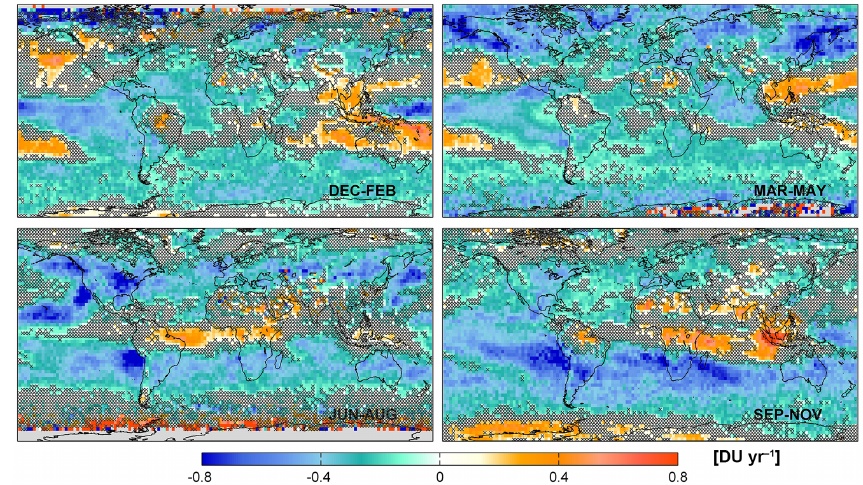
Figure 7. Seasonal distributions of the fitted linear term trends (given in DUyr − 1 ) derived from a single linear regression model. The crosses refer to the non-significant grid cells in the 95% confidence limits (2 σ